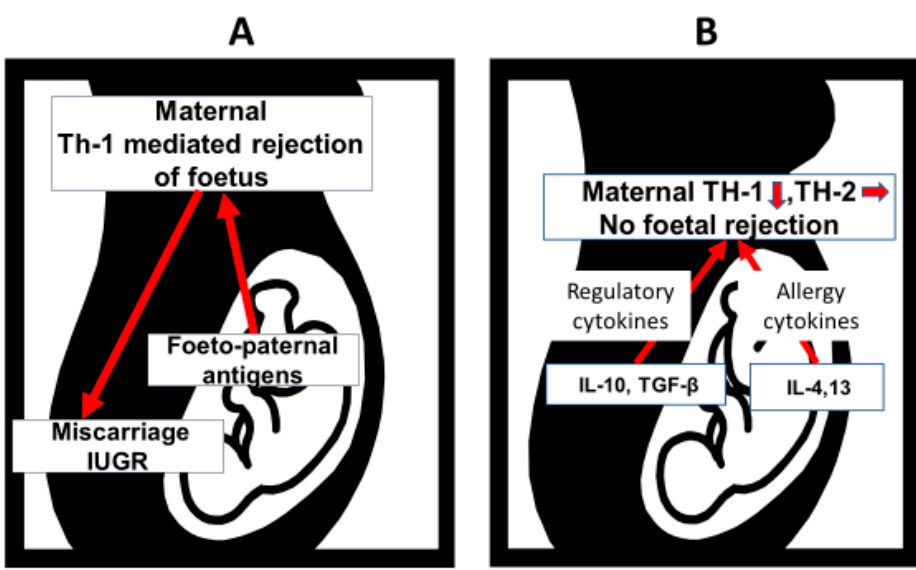
Figure 2. A schematic representation of components of the immunological interactions between mother and foetus. As the foetus and decidual tissues express paternal as well as maternal antigens, a maternal Th-1 tissue rejecting response might be expected, which would compromise the pregnancy with either intra-uterine growth retardation (IUGR) or early miscarriage ( A ). Part of the mechanism to protect the pregnancy is a regulatory and allergy promoting cytokine milieu at the foeto-maternal interface which protects the foetus from maternal Th-1 rejection of foeto-paternal antigens ( B ). The arrows indicate the direction of effect.